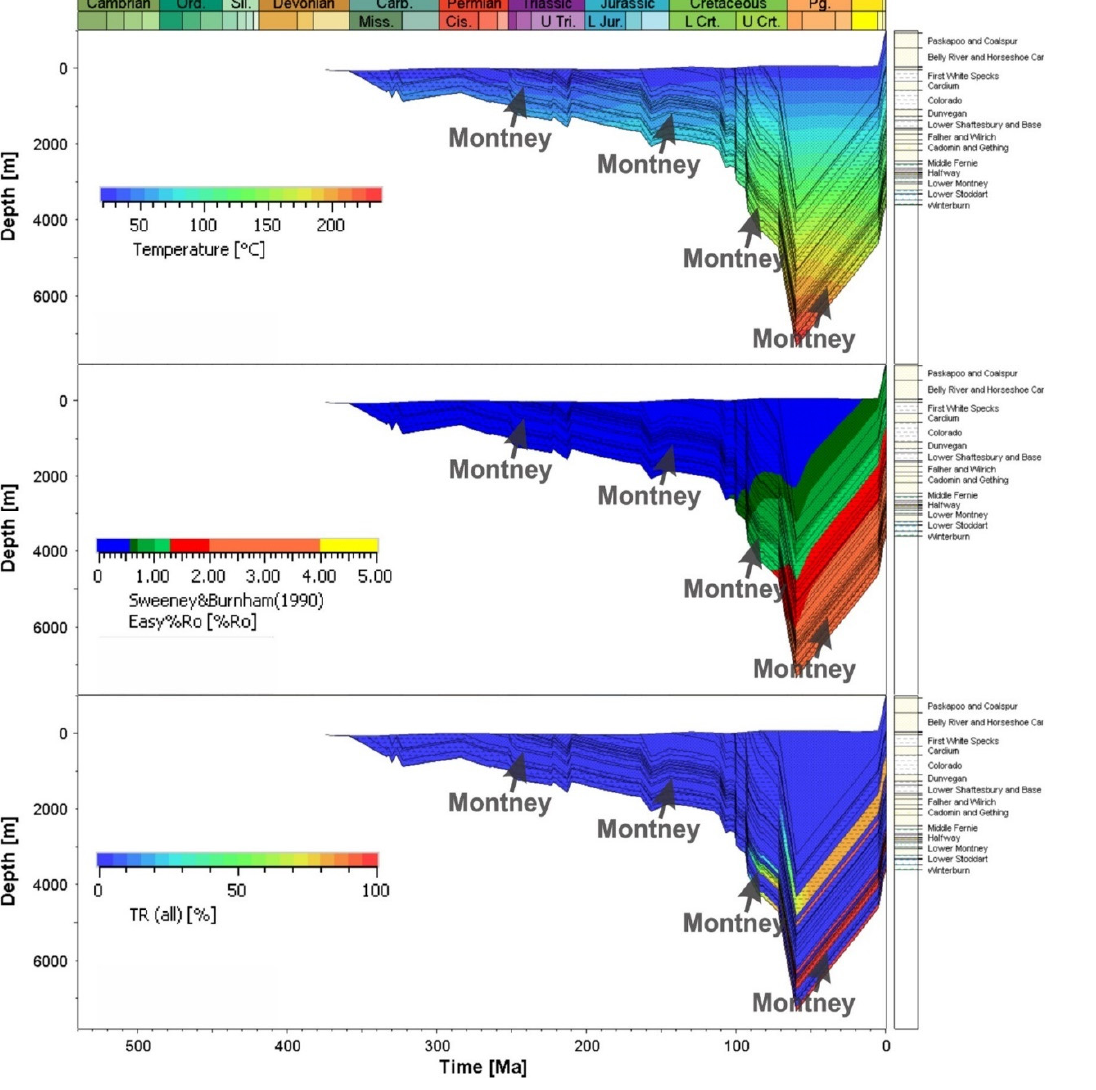
Figure 13. One-dimensional burial history of the basin at a location in BC shown in Figure 2 (white circle), highlighting the Montney Formation and showing temperature, maturity, and transformation ratio as overlays (respectively, from top to bottom).